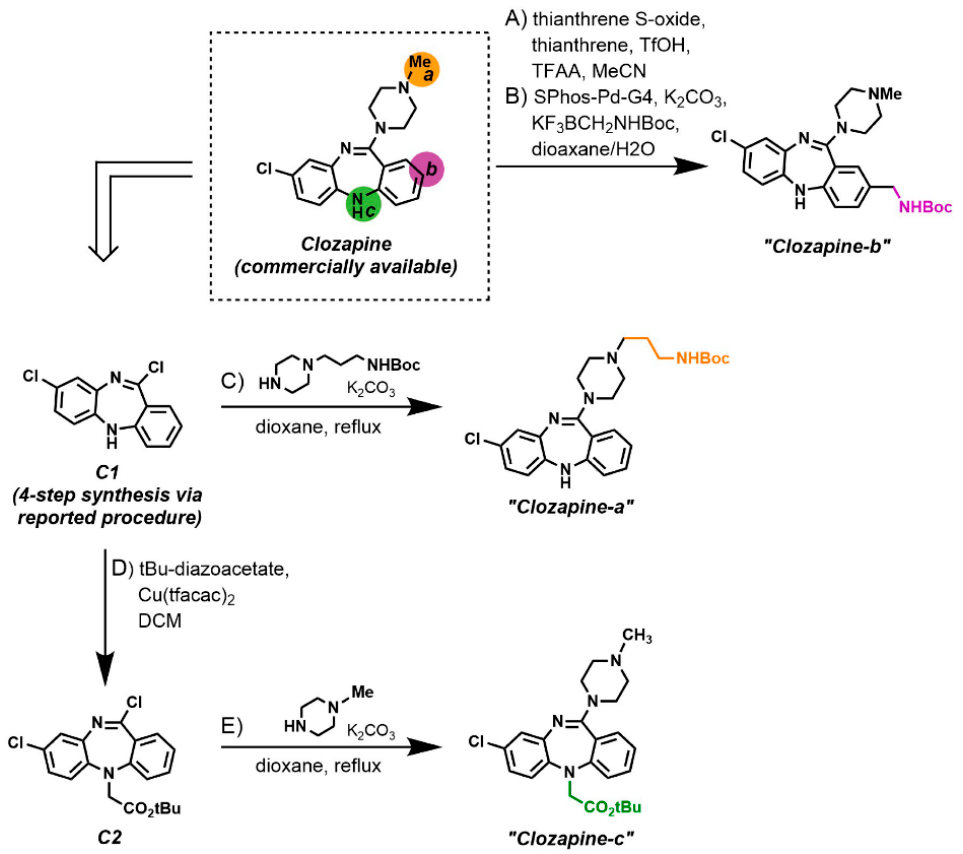
Figure 3. Synthesis of modifiable Clozapine analogues. ( A , B ) Boc-protected “Clozapine-b” was